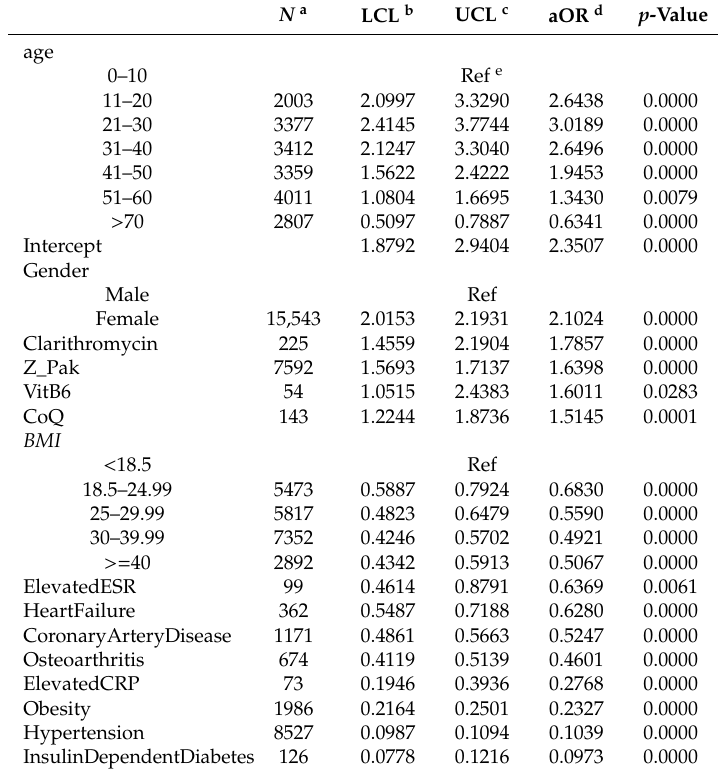
Table 6. Association of dietary supplements, antibiotics, and comorbidities for the disease. N